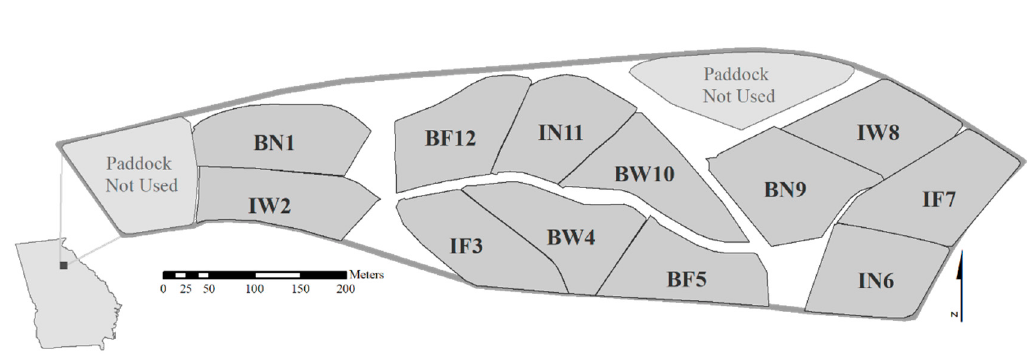
Figure 1. Study area within Watkinsville, Georgia comprised of 14 paddocks of tall fescue ( Schedonorus arundinaceus ). However, only 12 of the paddocks were incorporated here because two (“Paddock Not Used”) were subject to cutting for hay instead of cattle grazing. Each paddock was named based on if broiler litter (B) or inorganic (I) fertilizer was applied and if the tall fescue type was free of endophytes (F), novel–tall fescue MaxQ type with novel endophytes (N), or wild type endophytes (W), with two paddocks of each combination type within the study area (i.e., BF, IF, BN, IN, etc.). Table 1. Stocking rates for each paddock during the grazing periods. B: Broiler litter; I: Inorganic fertilizer; F: Endophyte free; N: novel–tall fescue MaxQ type with novel endophyte; W: Wild endo- phyte. Grazing Period # of Day s